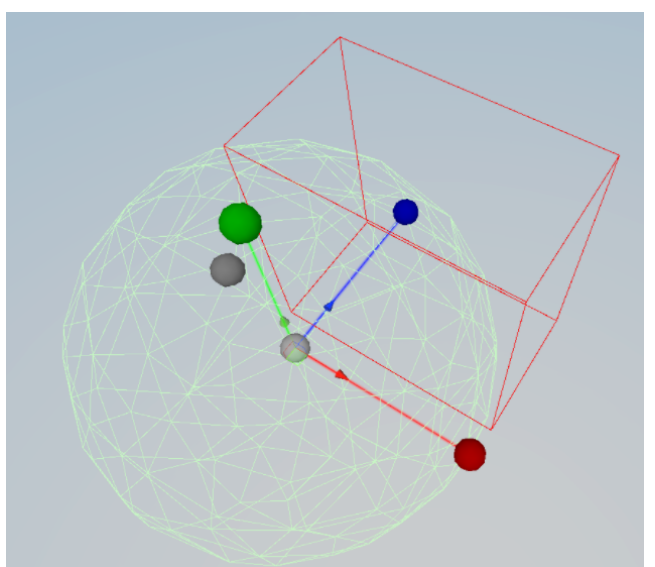
Figure 2. Calibration and curve creation. Light grey: shoulder position of the player; blue: forward; green: upward; red: right side. Light green lines represent the maximum reach of the player’s arm, and the red cuboid shape shows the points that can be chosen for the current configuration. With these, Bézier curves are procedurally